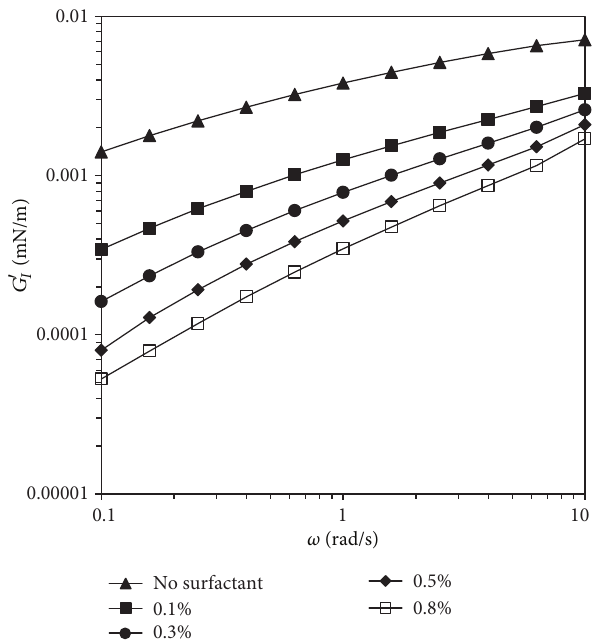
Figure 4: Effect of surfactant concentration on interfacial storage modulus of copolymer at different frequencies in deionized water at 25 ∘ C.